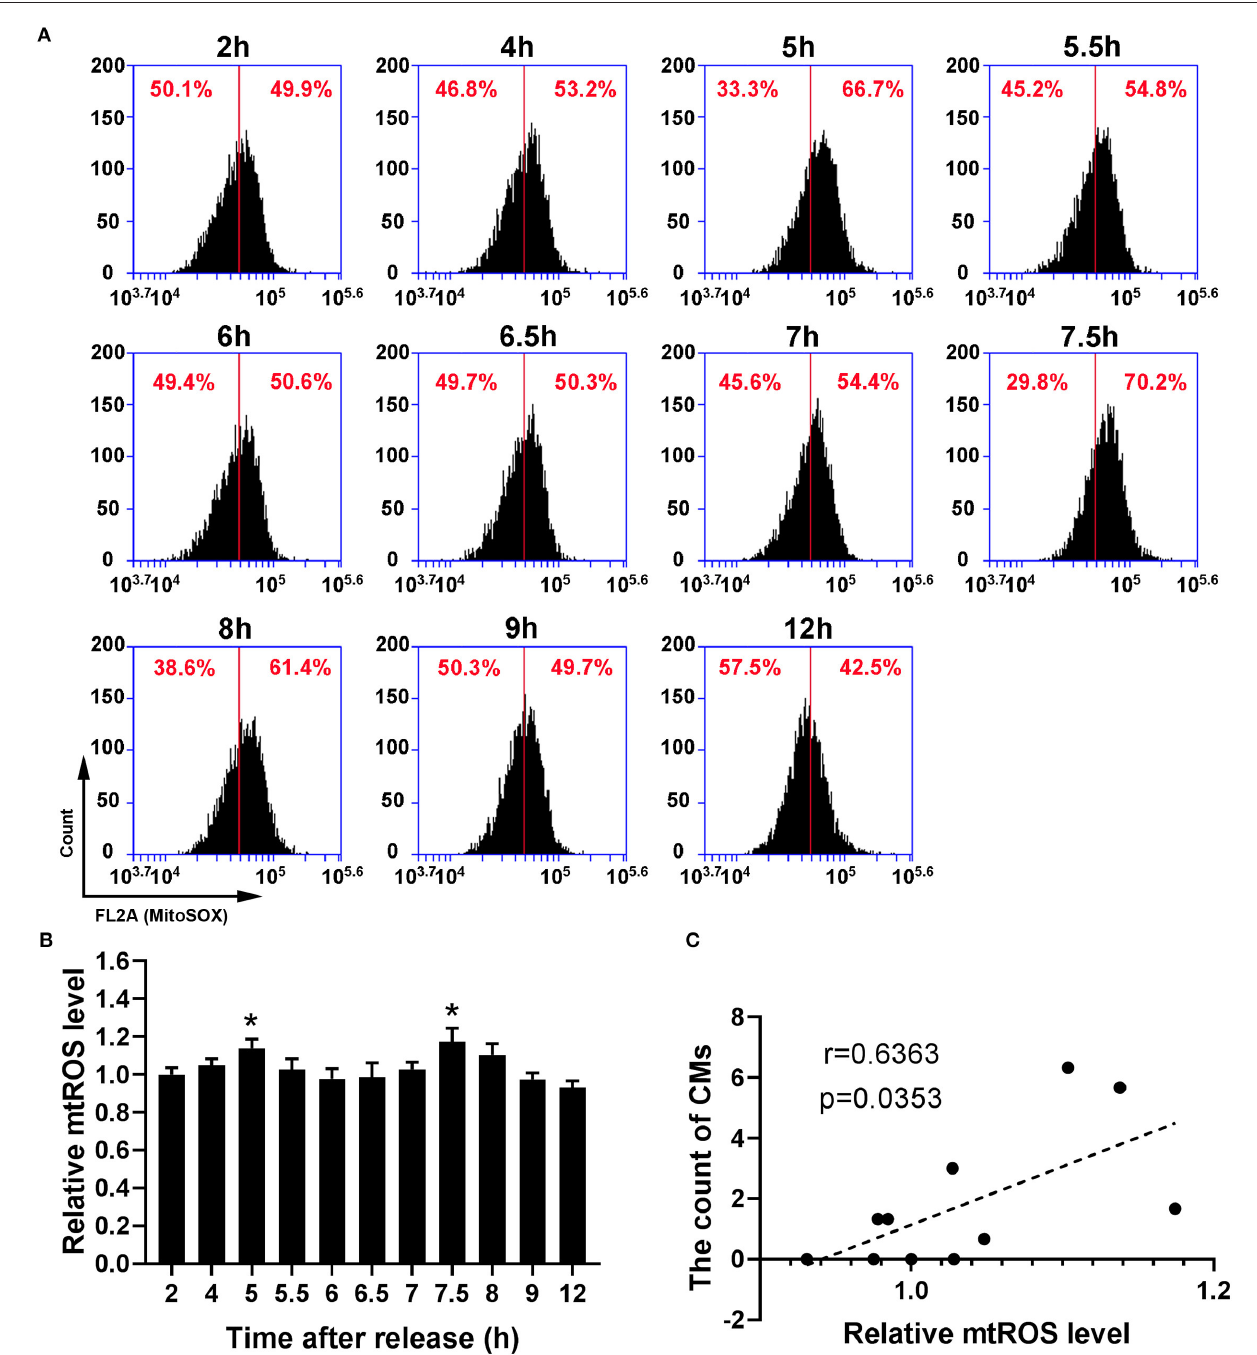
FIGURE 5 | The presence of CMs in G2 phase was correlated with mtROS level. (A) Representative charts showing the shift of mtROS peaks after releasing from S phase which were detected by flow cytometry, and the middle line was as a reference. (B) The change of mtROS levels at indicated time points was shown by analysis of fluorescence intensity. All data were expressed as the means ± SD; N = 3. * P ≤ 0.05, compared to the 2h group. (C) The correlation between the average count of CMs and relative mtROS level was shown by Pearson’s correlation